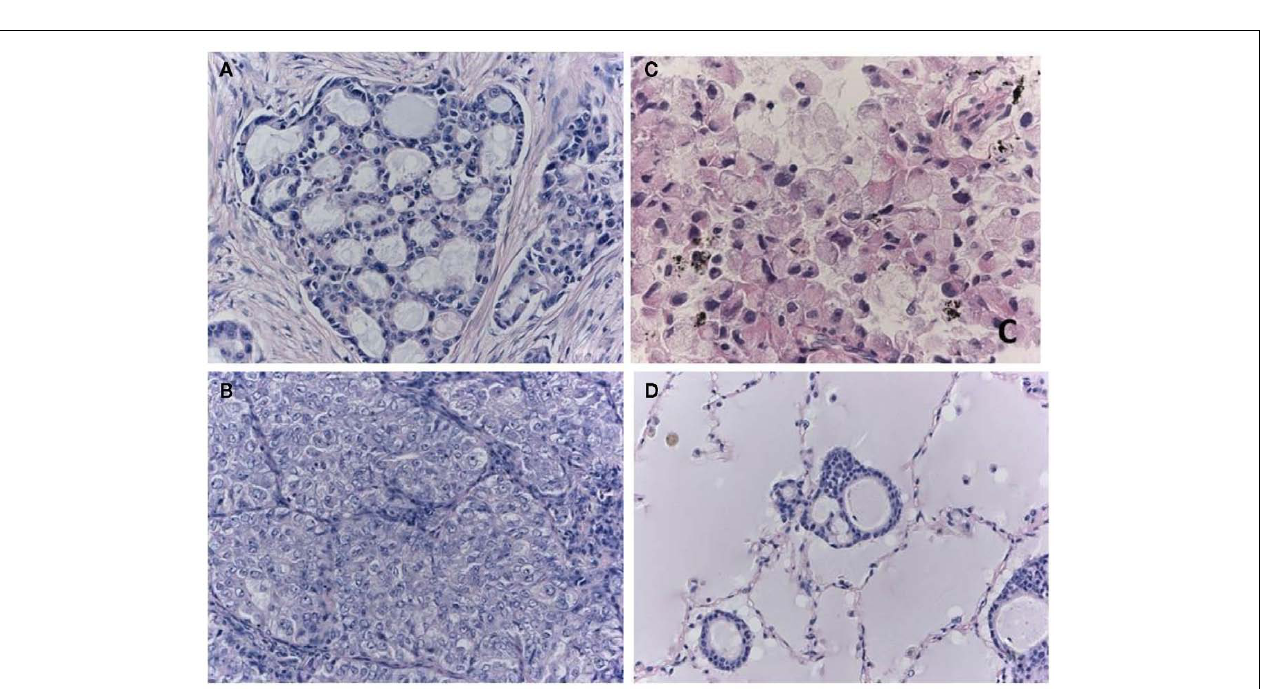
FIGURE 1 | Concentration of EML4–ALK translocation using clinicopathologic features ( n = 345). Numbers in black squares indicate number of patients with ALK translocation. Incidence of ALK translocation